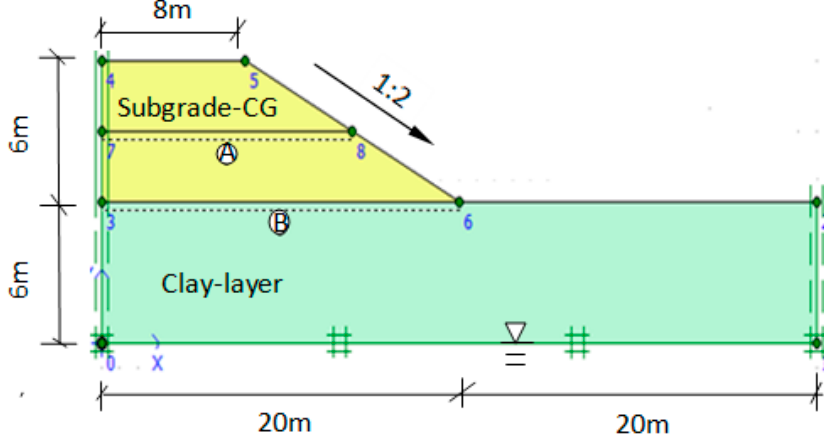
Figure 1. Model of coal gangue subgrade.